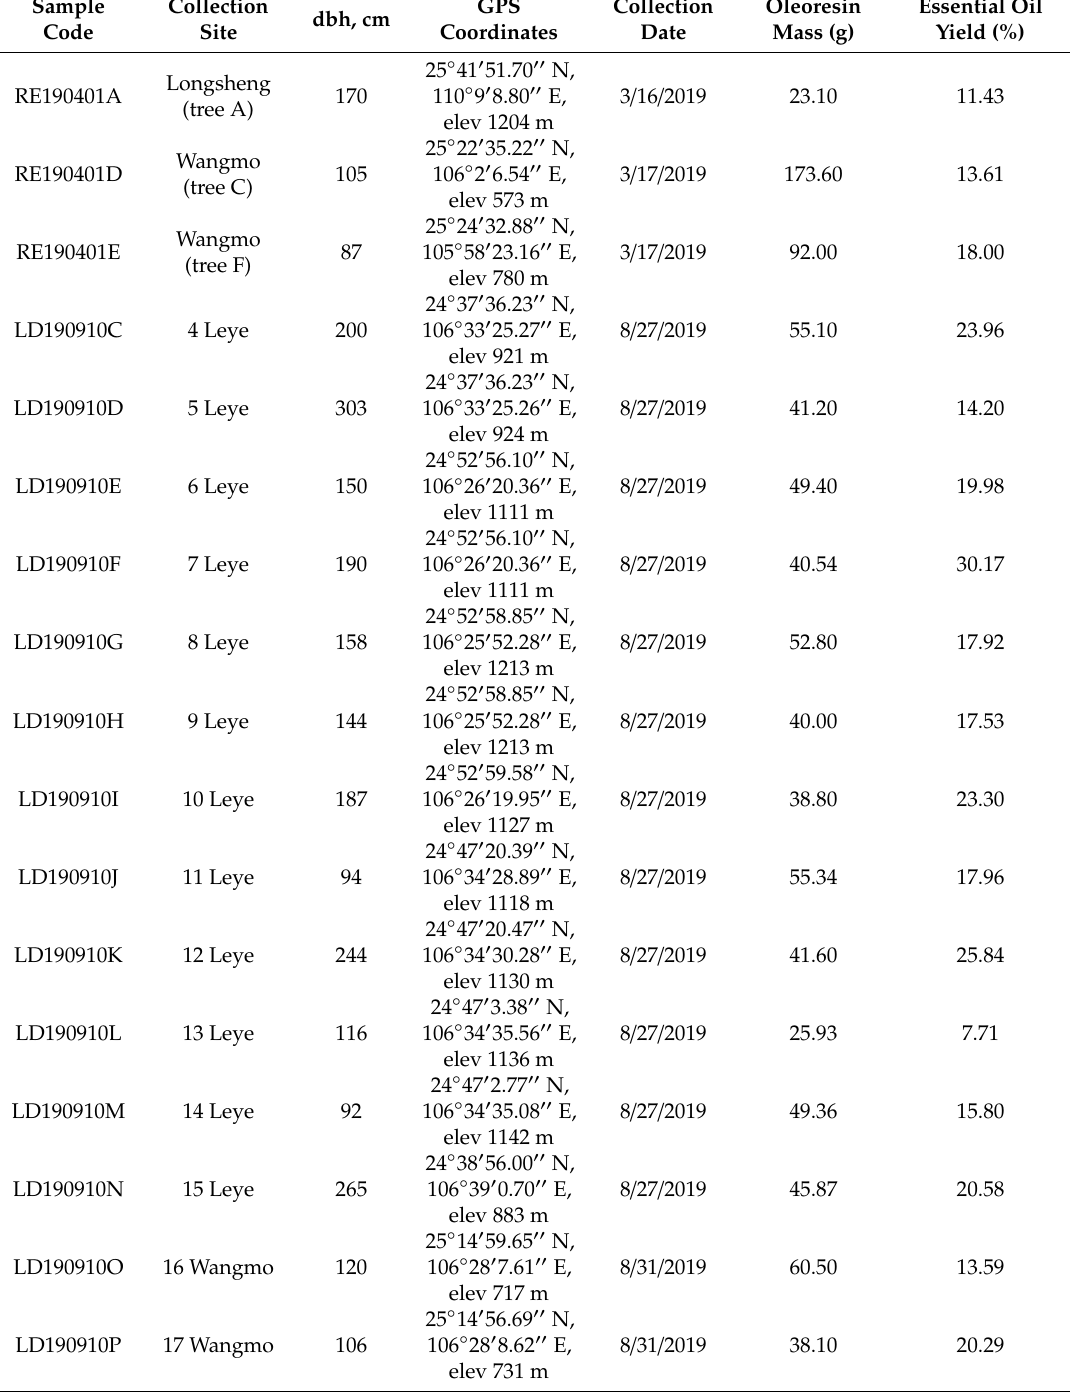
Table 1. Liquidambar formosana oleoresin collection